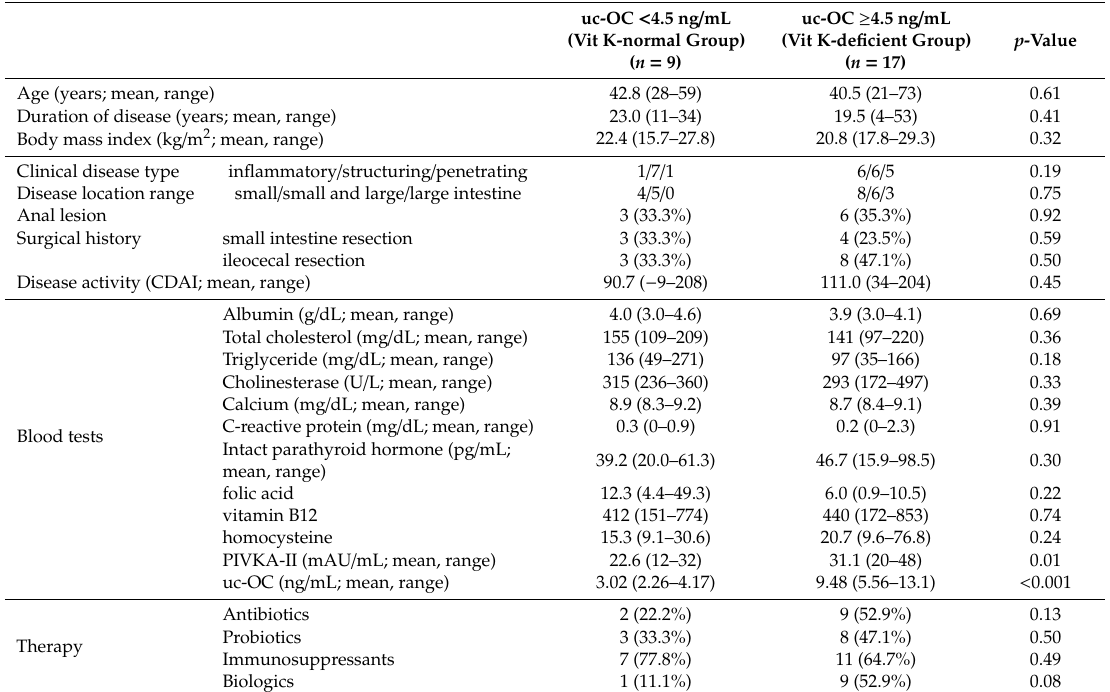
Table 1. Characteristics of the patients for the two groups, based on levels of undercarboxylated osteocalcin.